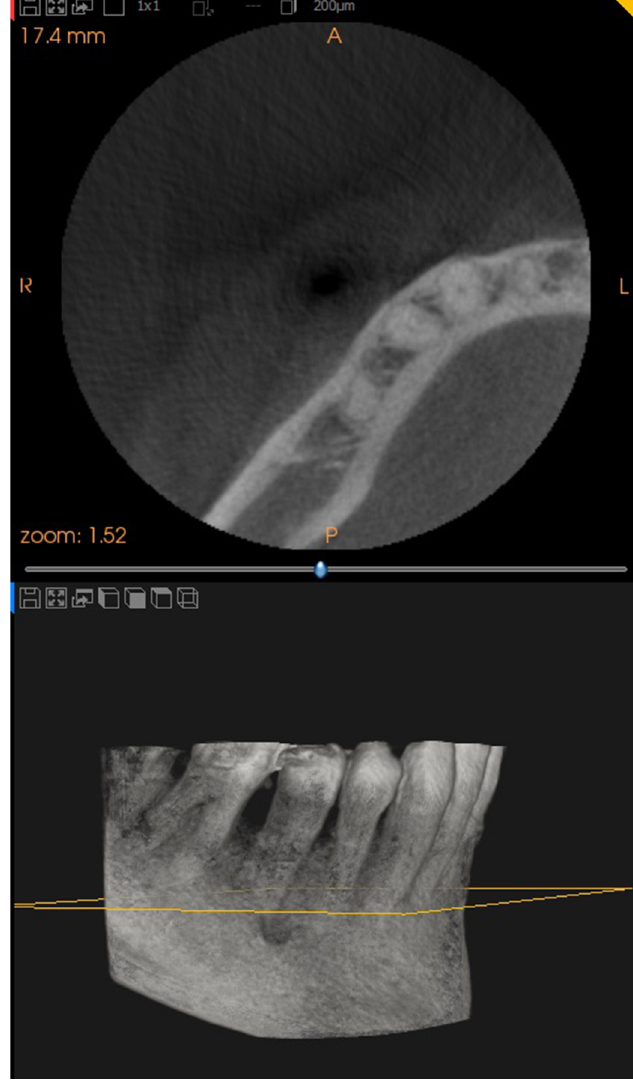
Fig. 3. Computed tomography focus on sector 4: